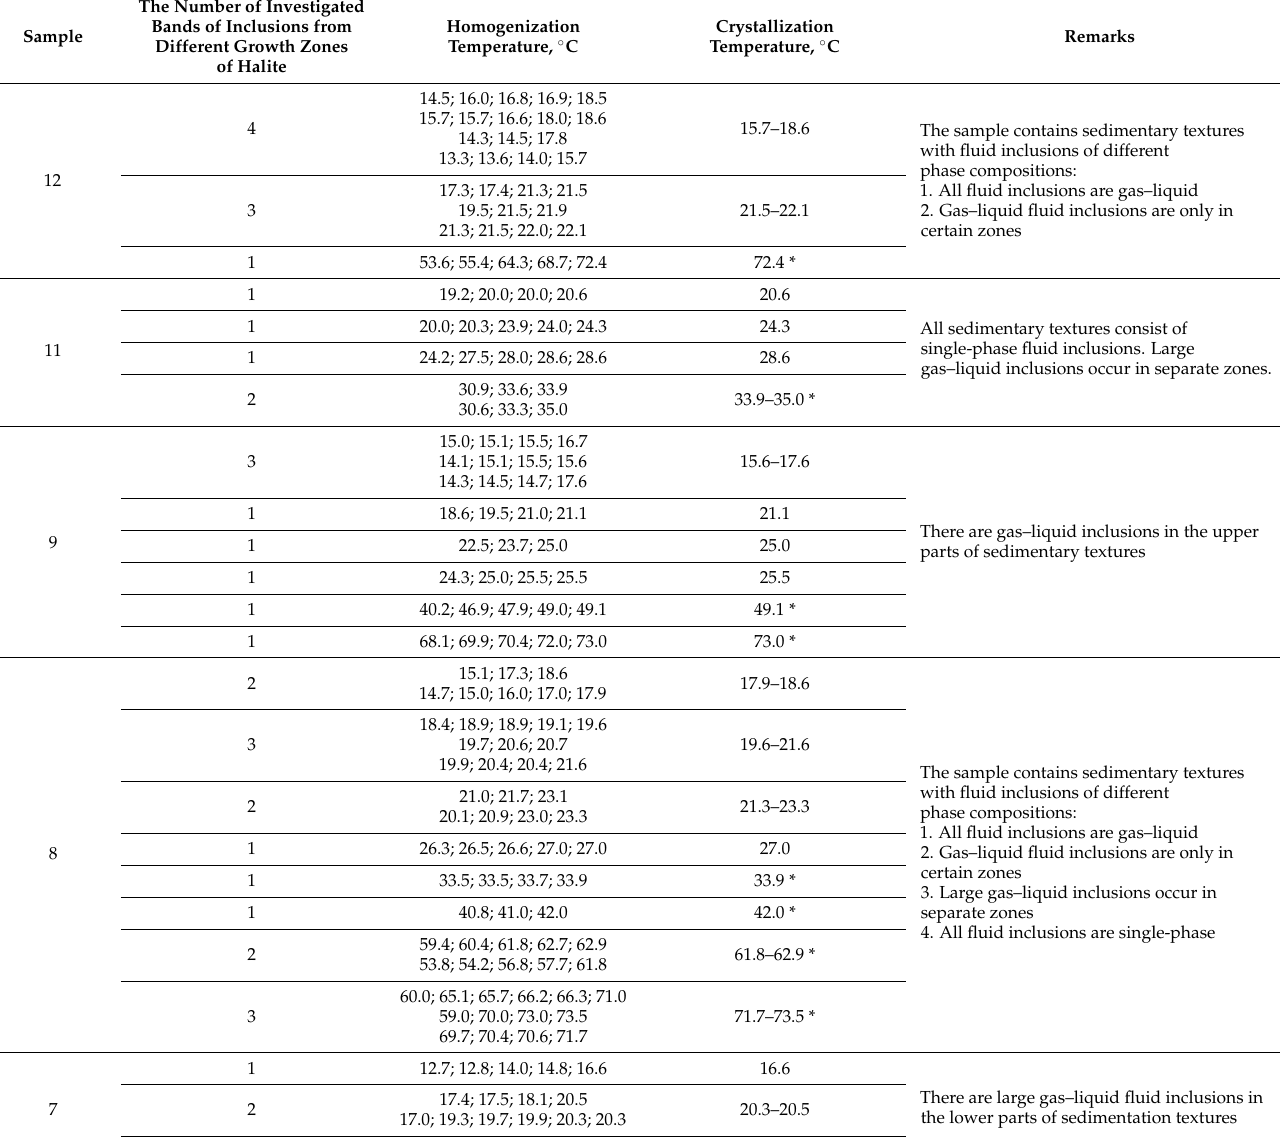
Table 3. Homogenization temperature of liquid–gas inclusions in halite of well TG6. For sample location, see Tables 1 and